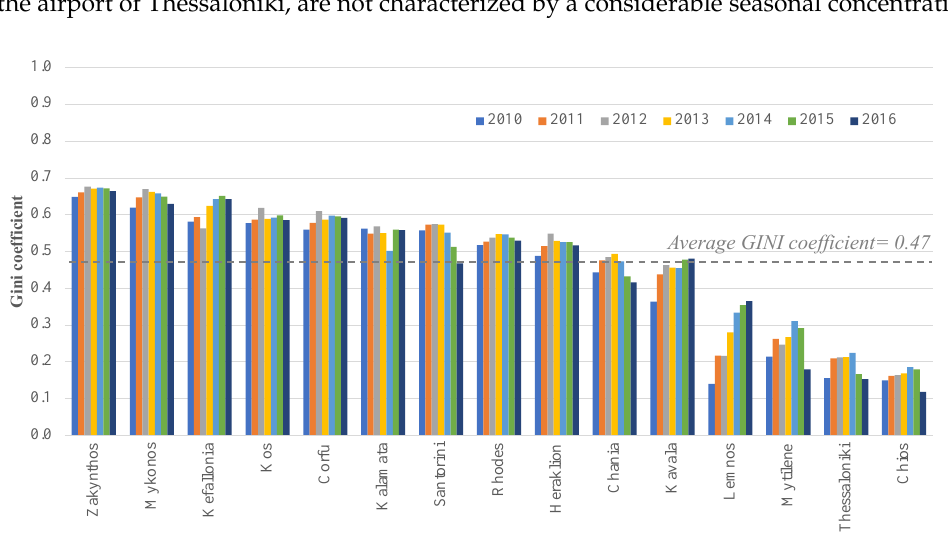
Figure 3. Gini coefficient for each airport across the study period (2010 – 2016).